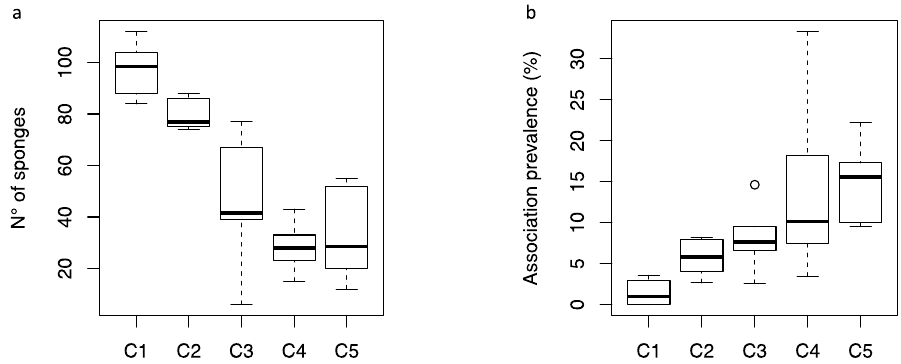
Figure 4. Hosts’ size class distribution and prevalence analyses in the study area: ( a ) Number of sponges for each class size; ( b ) Prevalence of Nemalecium lighti –sponges association in relation to the host class size. The bold line in the middle of the boxes is the median value, the bottom part of the boxes is the lower quartile, the top part of the boxes is the upper quartile, the lines departing from the boxes are the lower and upper extremes, and the circle is an outlier value.